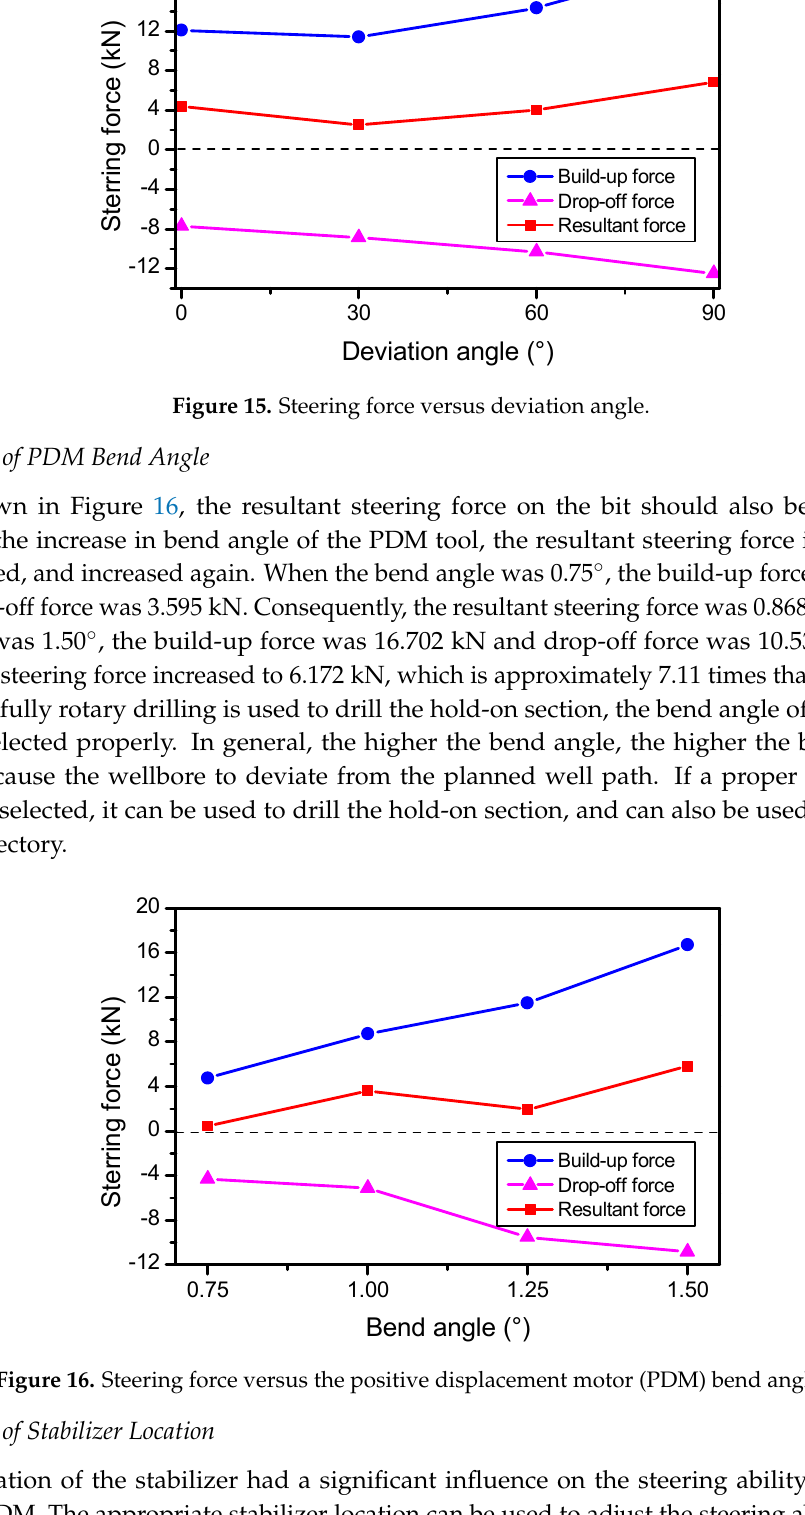
Figure 17. Steering force versus stabilizers’ location.